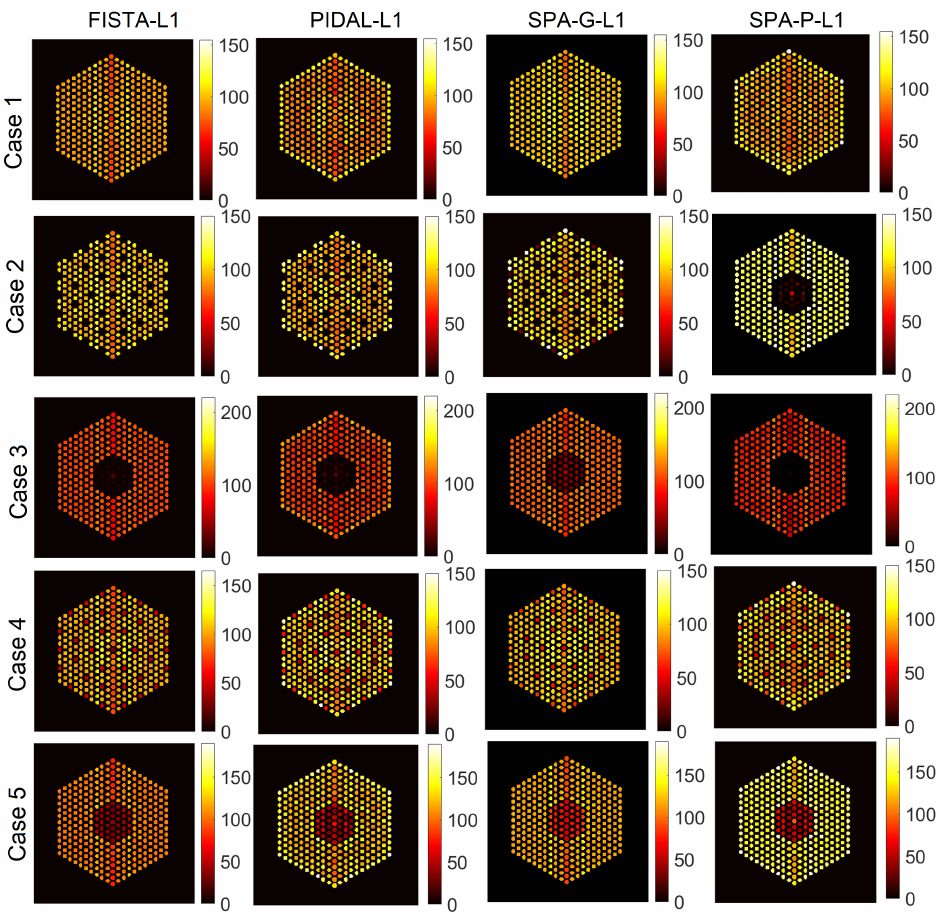
Figure 20. The FULL response matrix: activity estimation using pin pixels averaging using existing methods for the five cases. The regularization parameter β was set to 1 × 10 − 5 in the four